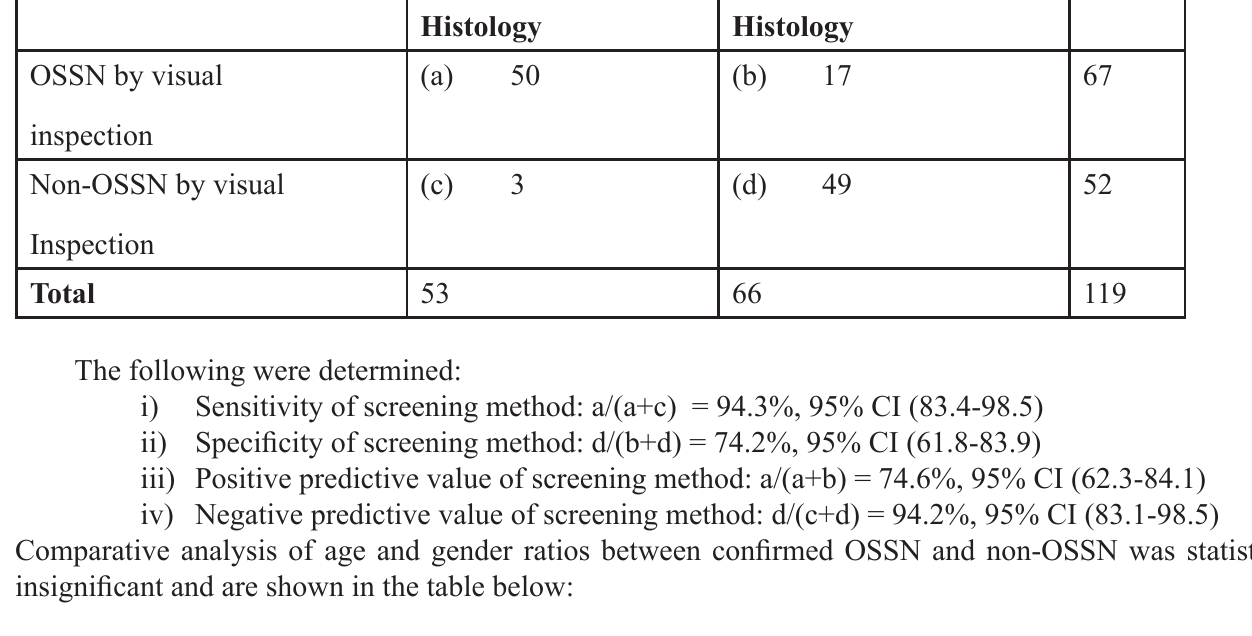
Table 2: Comparative analysis of gender and age distribution between confirmed OSSN and non-OSSN groups.